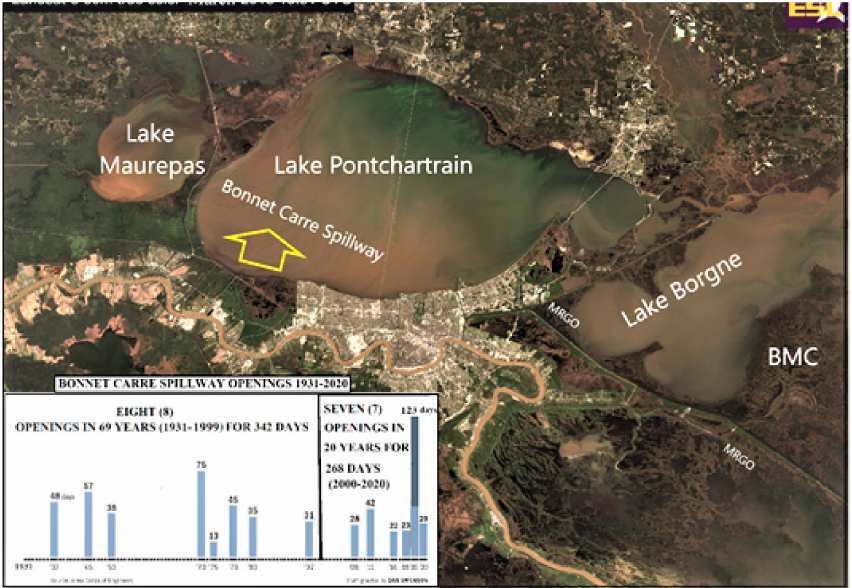
Figure 9. Landsat-8 30 m true-color image showing suspended sediment plume from the Bonnet Carr é Spillway in Lakes Pontchartrain and Borgne on 6 March 2019, after the second opening of that year. INSET: Increased usage of Spillway; 8 times in first 70 years; 7 times since 2000 (20 years). Satellite image adapted from LSU Earth Scan Laboratory [92]. Bonnet Carr é Spillway openings graphic modified from The Advocate